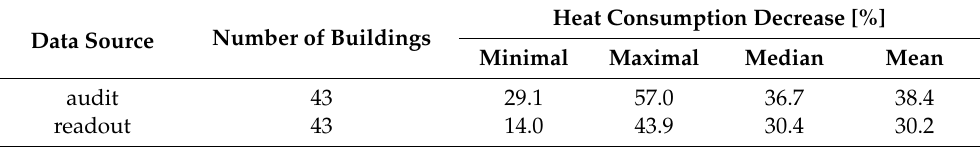
Table 7. Percent decrease in heat consumption in relation to the value from the